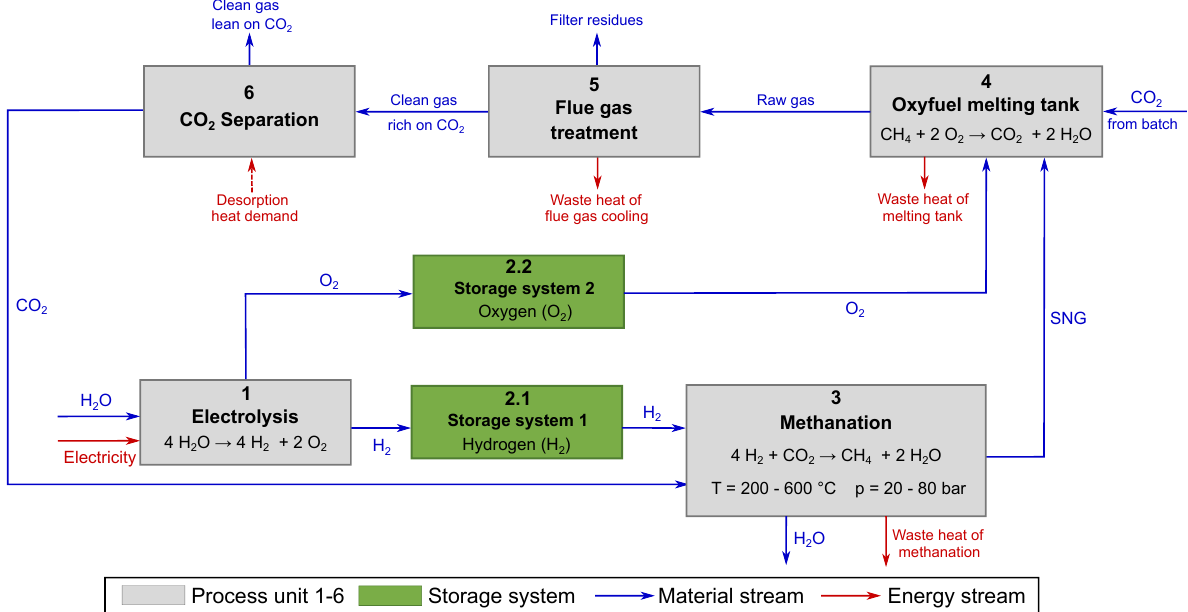
Figure 1. Simplified flow sheet of the integration of power-to-methane (PtM) into oxyfuel glass melting